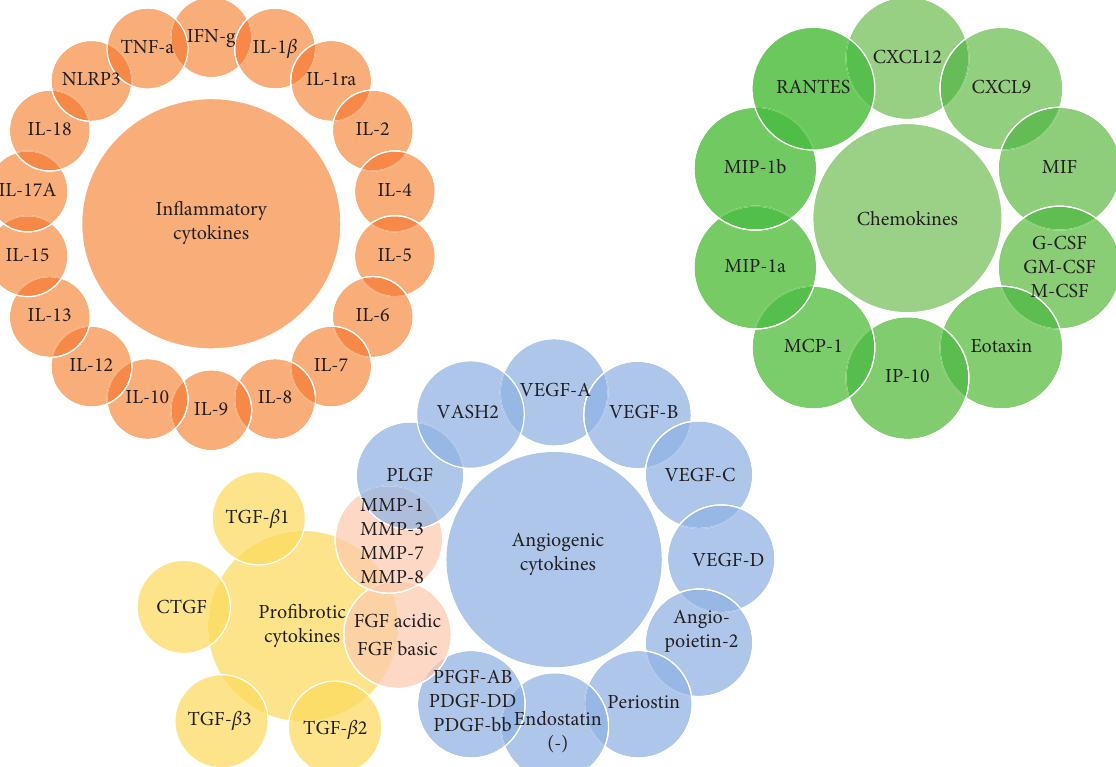
Figure 1: Cytokines measured in this study. The cytokines can be classified into angiogenic (blue), inflammatory (orange), profibrotic cytokines (yellow), and chemokines (green). Such MMP and FGF cytokines were both profibrotic and angiogenic